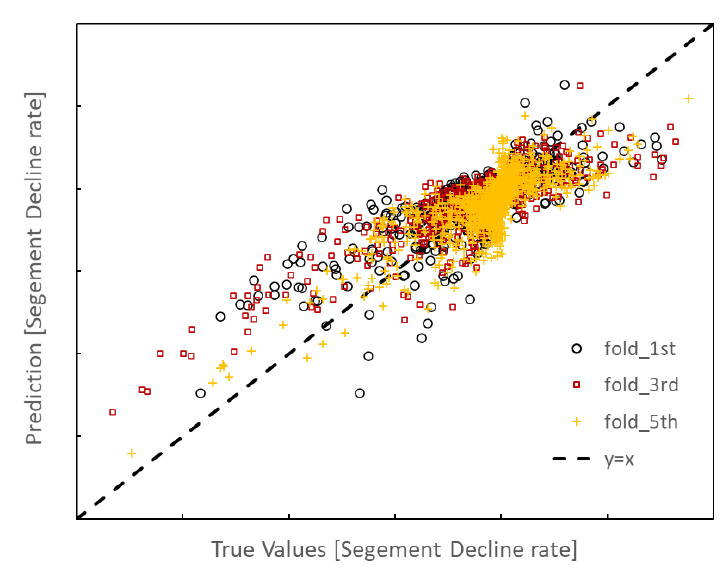
Figure 10. The cross-plot between the true value and the predicted value of the oil decline rate with k-fold cross validation test (k = 5).